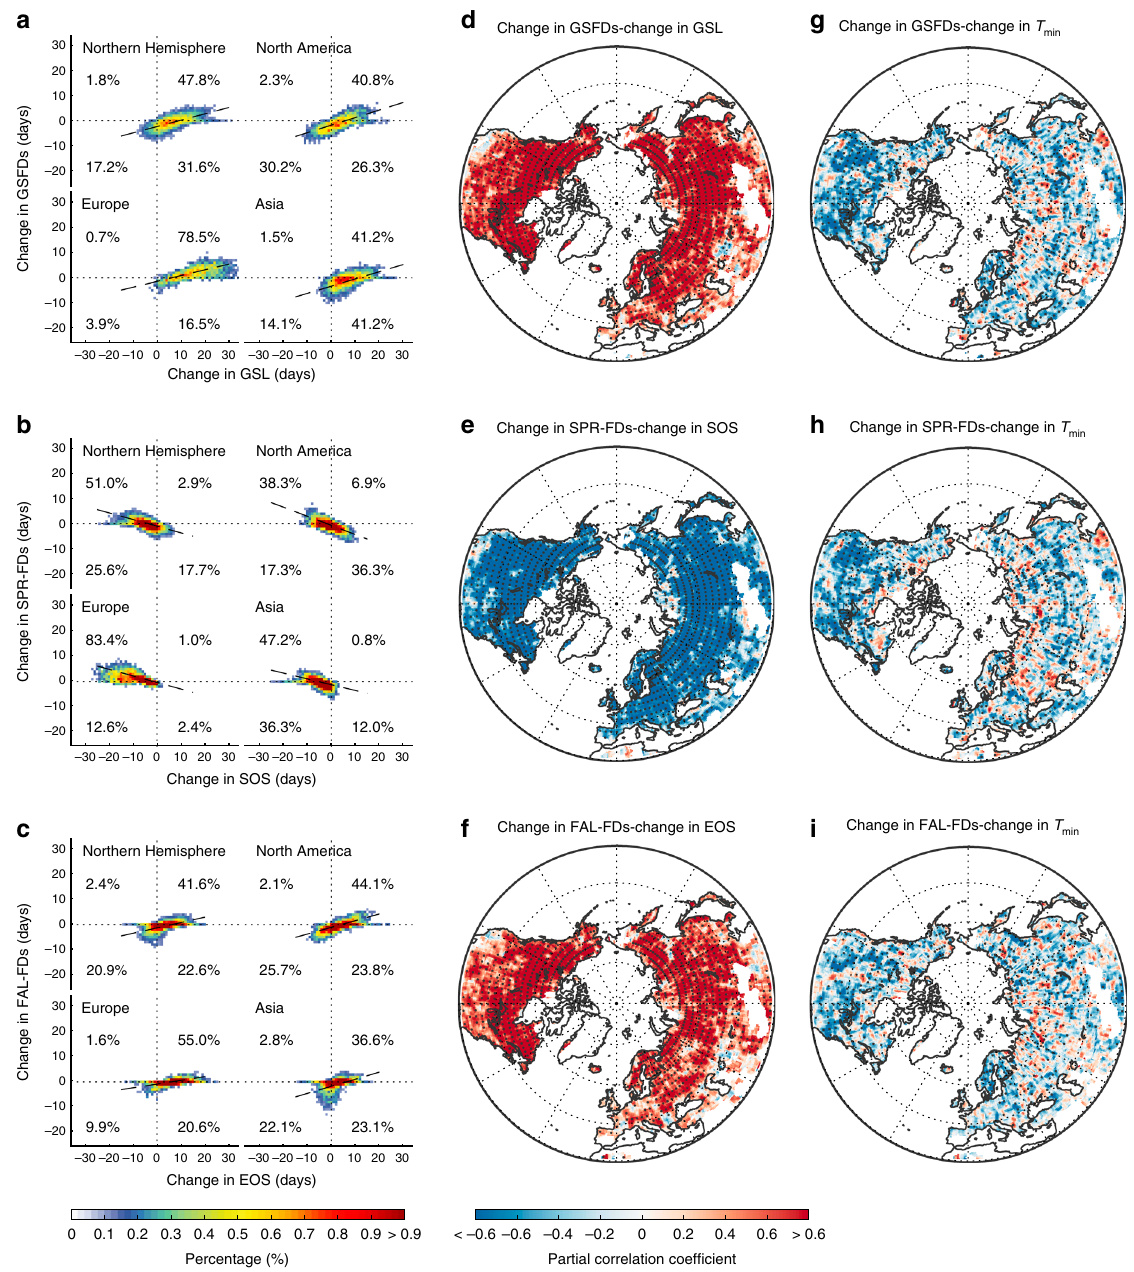
Fig. 3 Relationship between the changes in phenology and corresponding frost days. This relationship is presented between the 1980s and the 2000s at both continental and local scales. The number of frost days was averaged from the results of the Princeton and WFDEI data sets. The colors in the left panels ( a – c heating plots with percentage of pixels in each quadrant, continental scale) indicate the proportions of pixels that fall within each binned area (i.e., every 1 day in the changes of the number of frost days and phenology) in the Northern Hemisphere. The center ( d – f ) and right ( g – i ) panels display the spatial partial correlations between changes in the number of frost days with phenology and T min , respectively, using a moving window of 2.5 × 2.5° (i.e., local scale). Dotted regions indicate the correlations that were signi fi cant at P < 0.05, t -test. Maps were created using Matlab